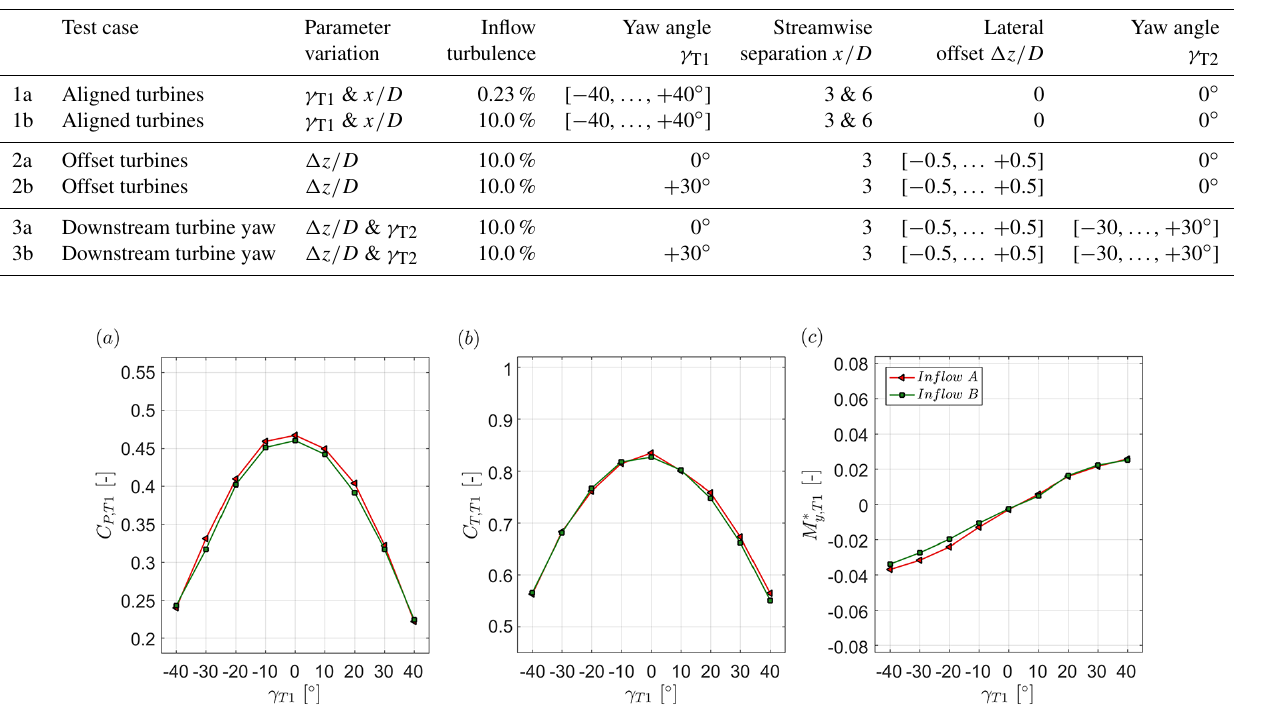
of the undisturbed upstream y , T1